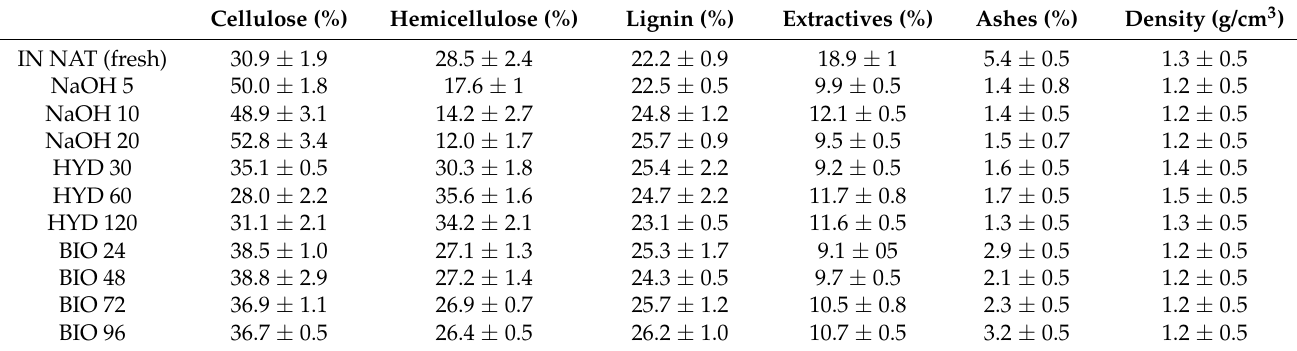
Table 2. Lignocellulosic composition and true density of fresh and treated